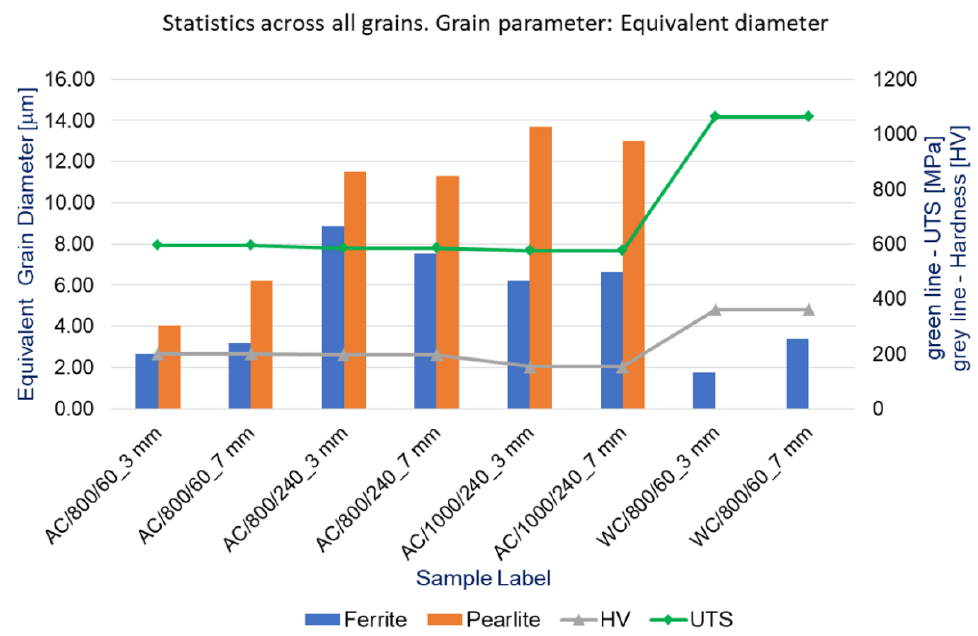
Figure 1. Diagram presenting dependence of microstructural indices, i.e., mean equivalent diameters of ferrite and pearlite grains, HV hardness, and ultimate tensile strength (UTS) on heat treatment parameters.